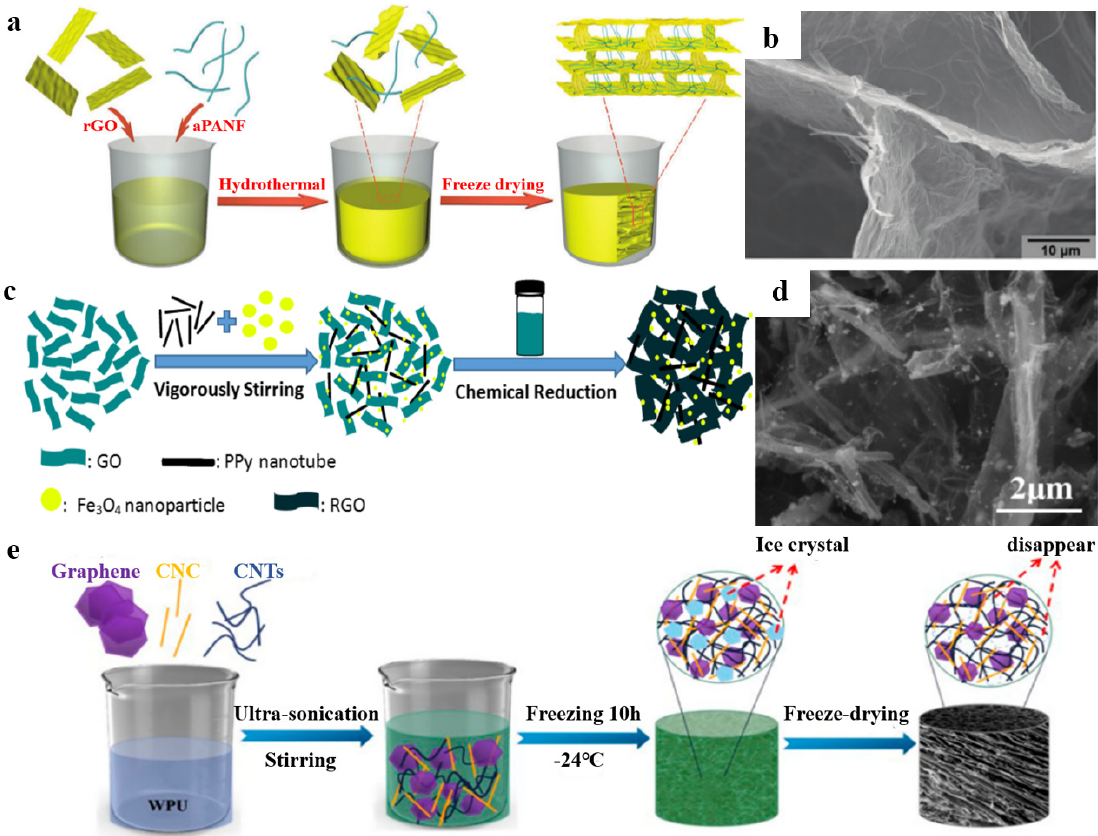
Figure 9. ( a ) The fabrication process of aPANF/GA. ( b ) The microstructure of aPANF/GA. Repro- duced with permission from [83]. ( c ) Schematic fabrication process of GPFA. ( d ) The SEM images of GPFA. Reproduced with permission from [84]. ( e ) Schematic illustration of the fabrication of the CNTs/graphene/WPU/CNC composite aerogels. Reproduced with permission from [85].